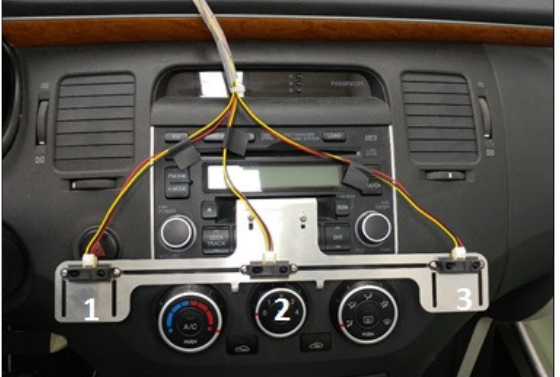
Figure 4. Positions of infrared sensors on the center console.